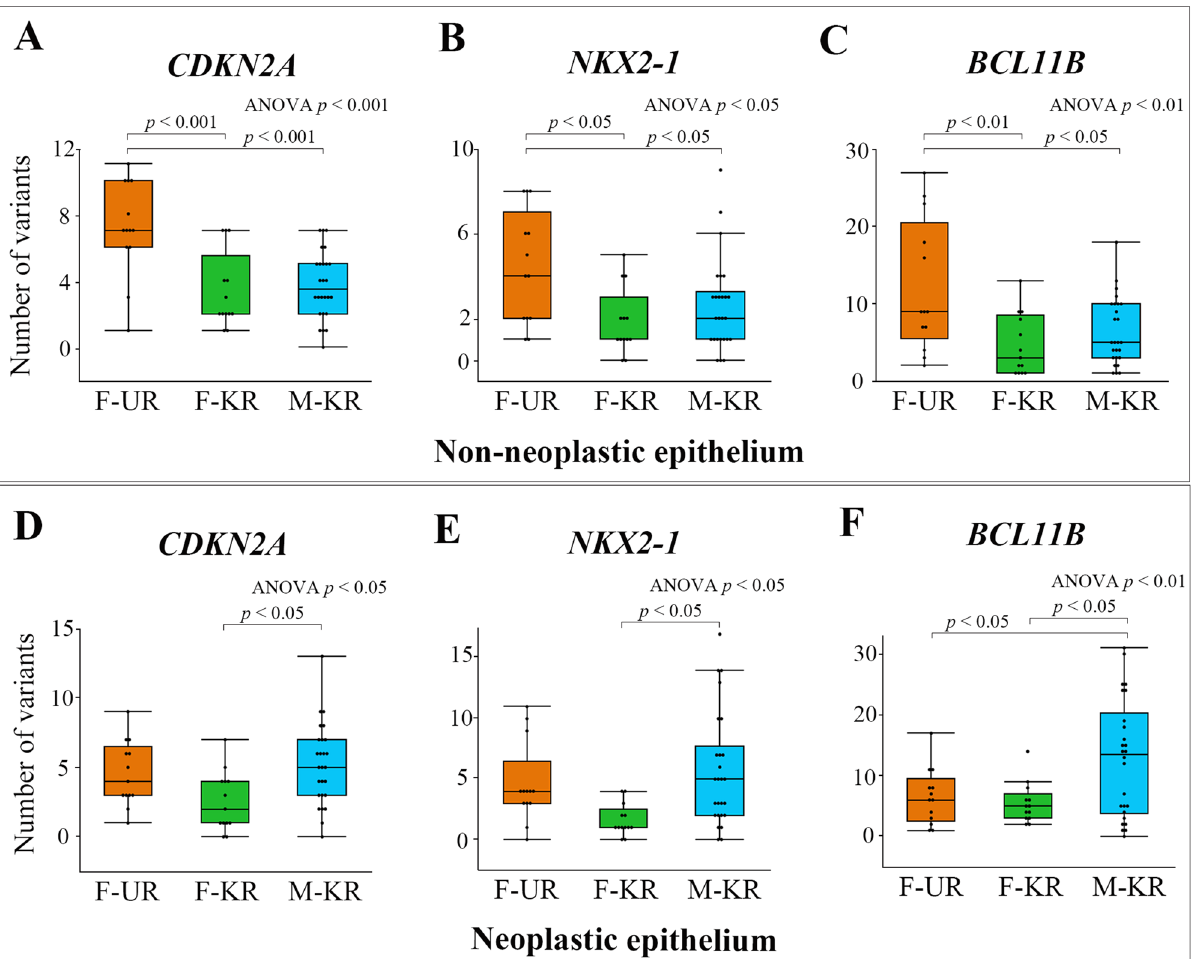
Figure 2. Comparison of the number of somatic variants in neoplastic and the adjacent non-neoplastic epithelium by risk factors. In adjacent non-neoplastic epithelium, the number of somatic variants of the CDKN2A ( A ), NKX2-1 ( B ), and BCL11B ( C ) genes were significantly higher in the F-UR group than in the F-KR and M-KR groups. In the neoplastic epithelium, the number of somatic variants of the CDKN2A ( D ), NKX2-1 ( E ), and BCL11B ( F ) genes were significantly different between the F-KR and M-KR groups, and the number of BCL11B gene variants was significantly higher in the M-KR group than in the F-UR group; however, there was no difference in the number of these three gene somatic variants in F-UR between either the F-KR or M-KR. Box plot: the bottom and top of each box represent the 25th and 75th percentiles, respectively, and the band in the box is the median. Whiskers: the lowest datum is within the minimum, and the highest datum is still within the 1.5 IQR of the upper quartile. We used ANOVA with a post-hoc Tukey–Kramer test to evaluate the statistical differences among the groups. Statistical calculations were performed using JMP 14.3.0. CDKN2A cyclin-dependent kinase inhibitor 2A; NKX-21 NKX homebox-1; BCL11B B-cell lymphoma/leukemia 11B; F-UR female unknown-risk; F-KR female known risk; M-KR male known risk; ANOVA analysis of variance; IQR interquartile